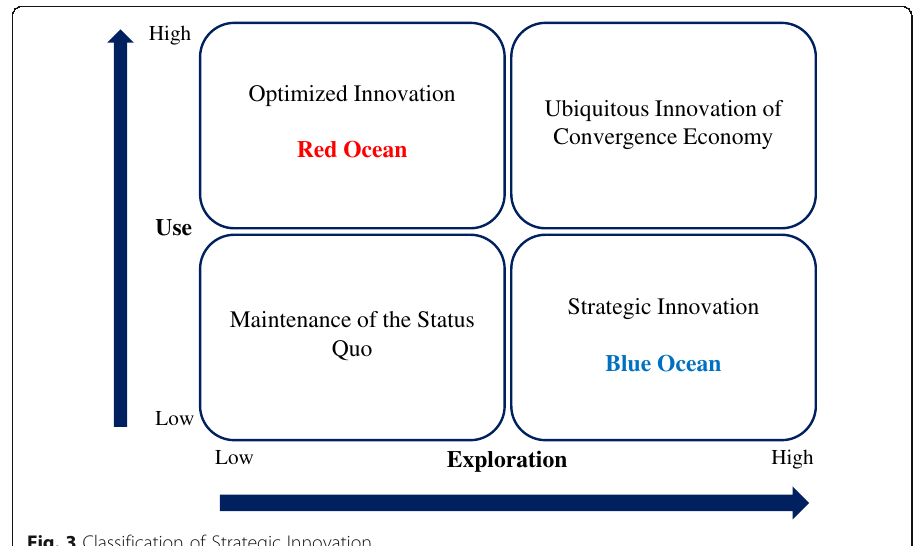
Fig. 3 Classification of Strategic